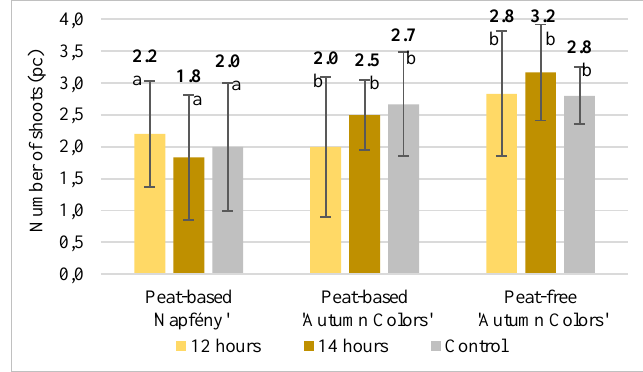
Figure 7. Number of shoots of 11 weeks-old Rudbeckia hirta L. varieties (’Napfény’, ’Autumn Colors’) depending on photoperiodic lighting treatments, peat-free and peat-based media (University of Debrecen, Biological Research and Plant Experiment Greenhouse - Biodrome, Debrecen, Hungary,